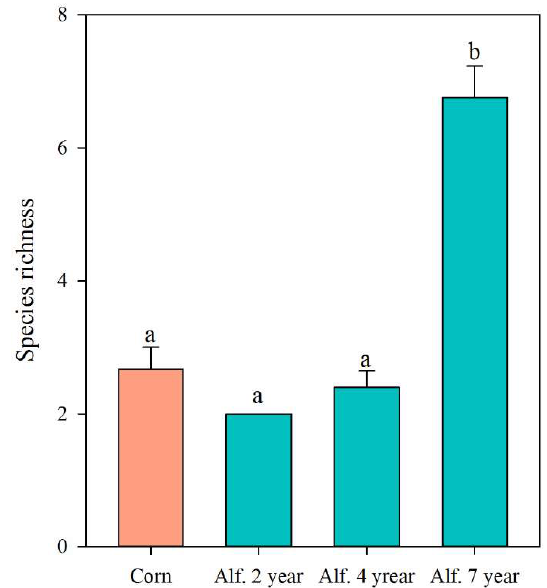
Figure 7. Species richness of the cornfield and the two-, four- and seven-year-old alfalfa pastures. Different lowercase letters indicate statistically significant differences at the 0.05 level.